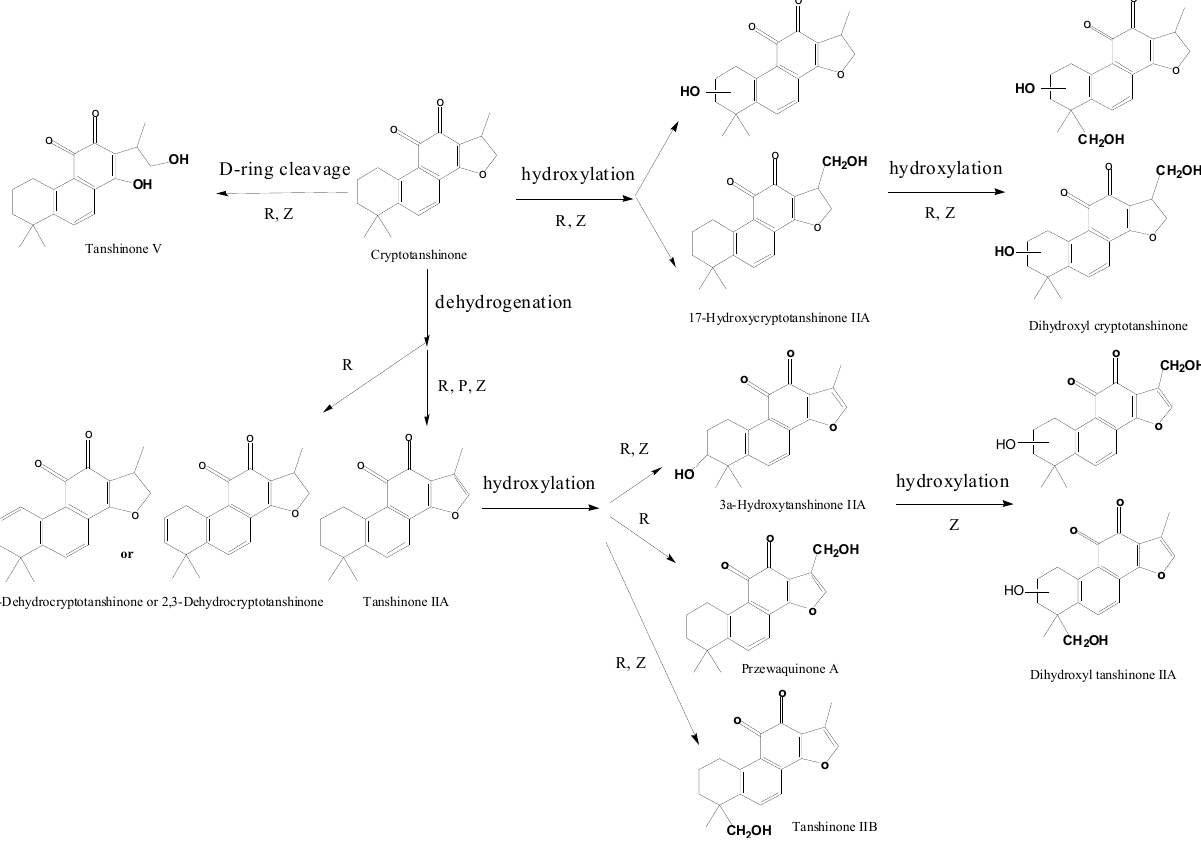
Figure 8. Comparison of metabolic pathways of Cry between zebrafish and the current metabolism data. R: Rat; P: Pig and Z: